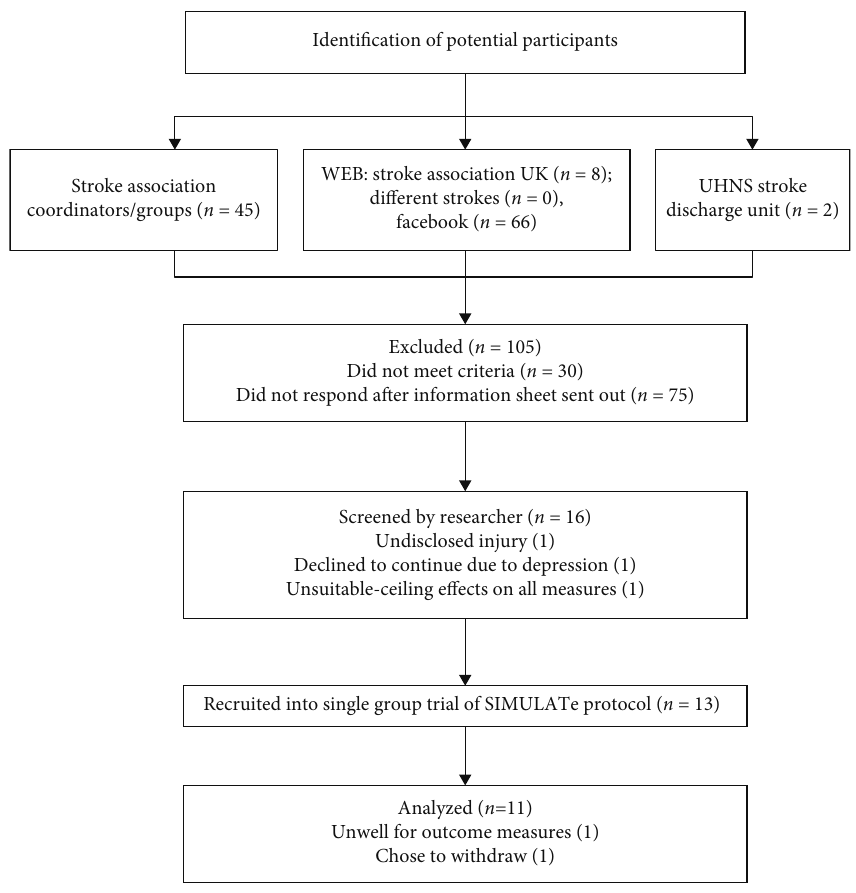
Figure 4: CONSORT diagram illustrating participant recruitment and retention.